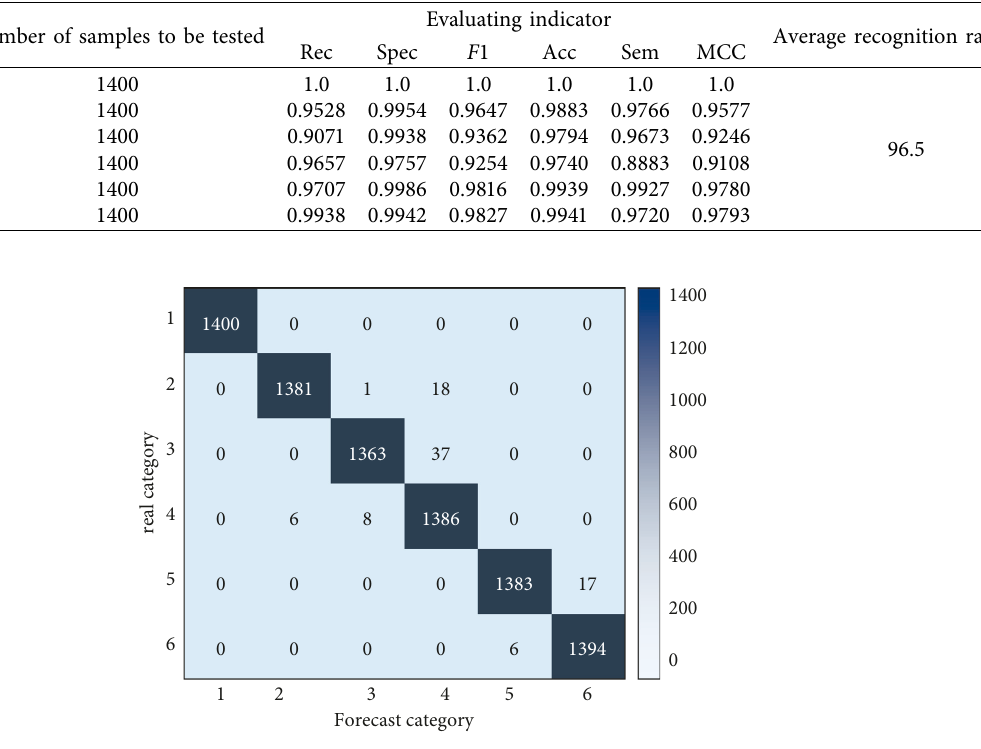
Table 1: XGBoost measurement results and analysis.